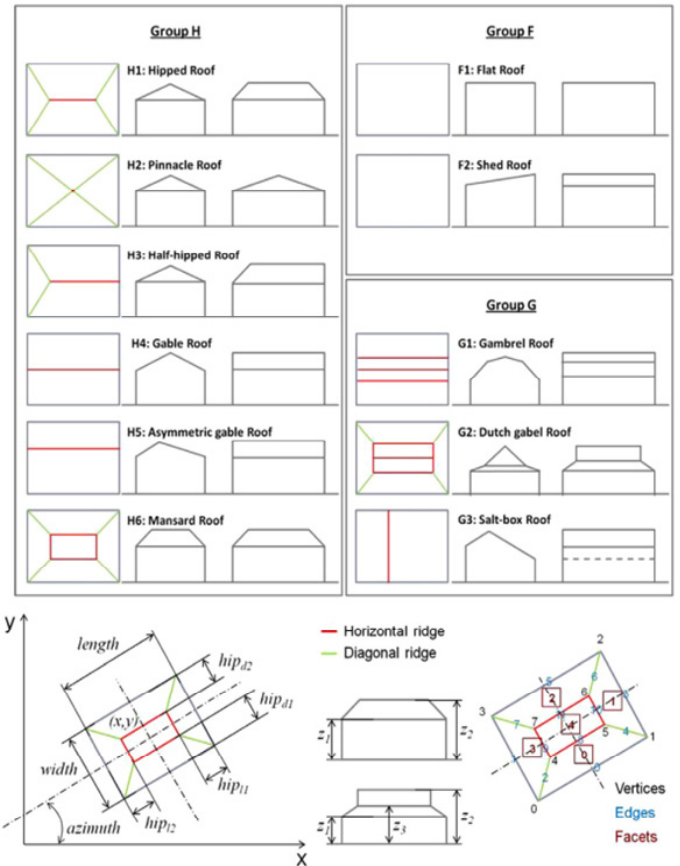
Figure 1. Representative building roof shapes [17].